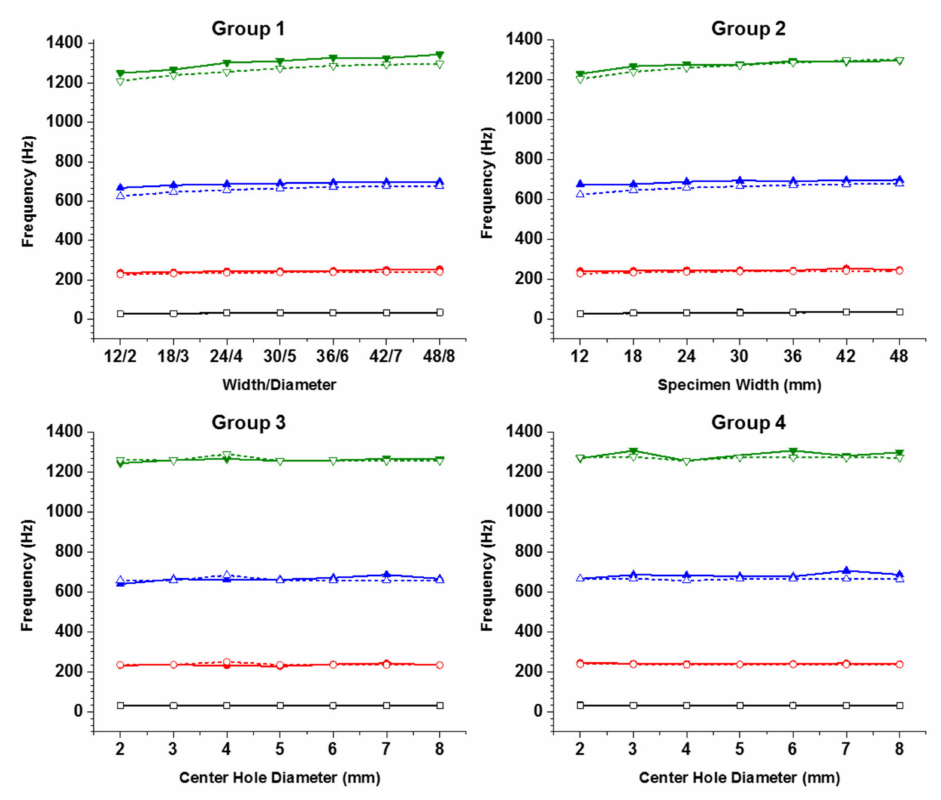
Figure 12. Comparison of experimental (closed symbols, solid line) and analytical (open symbols, dotted line) frequencies for all the specimens.